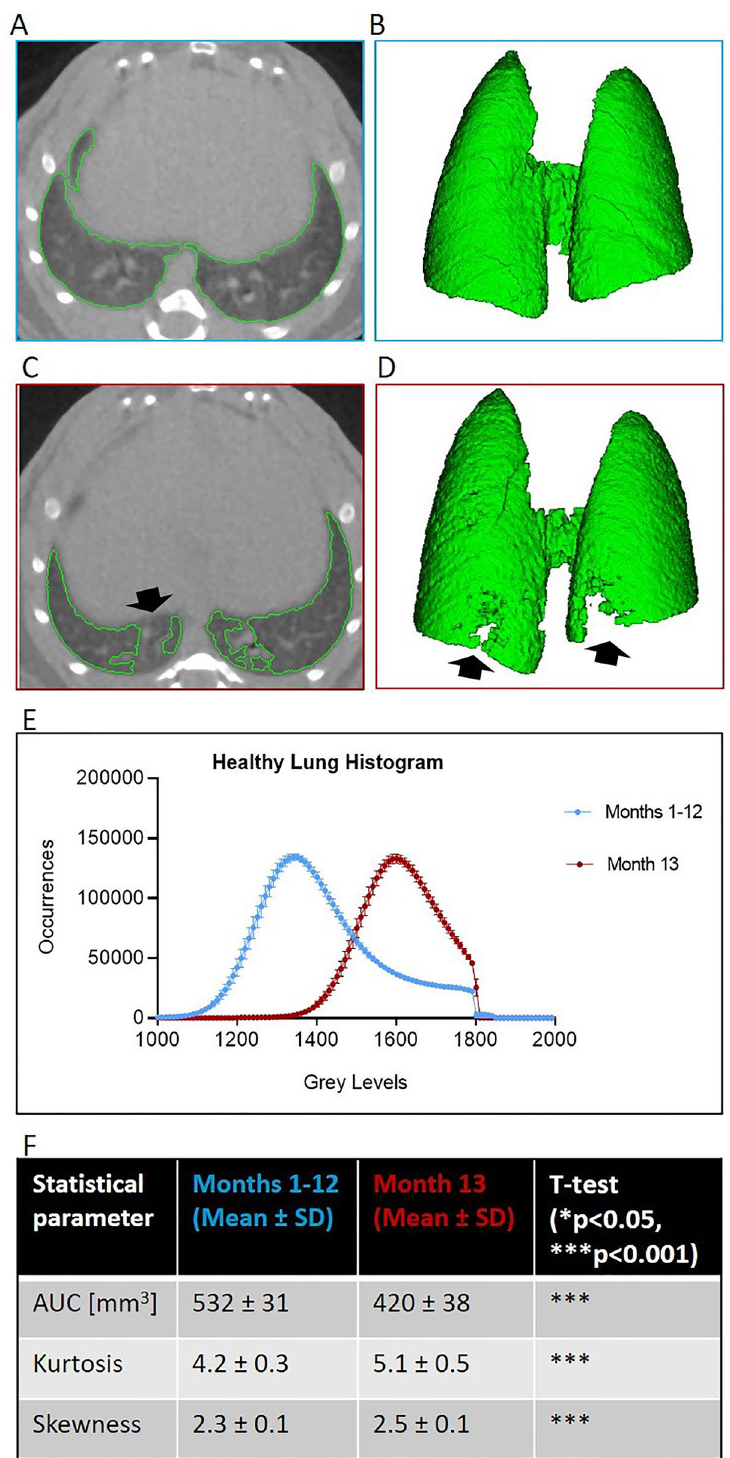
Figure 4. Effect of micro-CT scanner drift on image lung segmentation process. ( A , B ) A representative transversal slice of a saline mouse lung scan before the drift (1st–12th months): the lung segmentation map and the corresponding 3D rendering, obtained using an automatic segmentation, are highlighted in green. ( C , D ) A representative transversal slice and the corresponding 3D rendering of a saline mouse lung scan from the 13th month: the automatic segmentation fails to detect some healthy regions of aerated parenchyma (black arrows). ( E ) Lung mean grey levels density histograms before (1st–12th month: blue curve) and after (13th month: red curve) drift. Each point of the histogram is represented as mean ± SD. ( F ) Statistical comparison between the two average histograms in terms of AUC, Kurtosis and Skewness. All parameters are reported as mean ± SD. The alpha level of statistical tests is set at 0.05 (*p < 0.05, **p < 0.01, ***p <